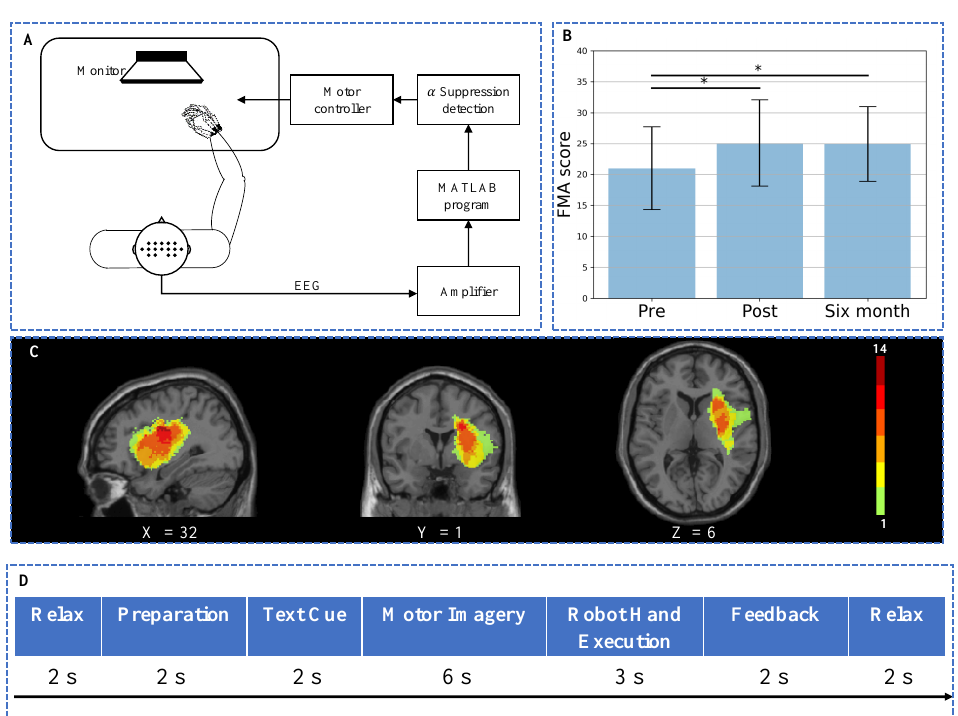
Figure 1. Illustration of the experimental settings and characteristics of subjects. ( A ) Schematic diagram of the whole training system. ( B ) Comparison of FMA score among pre-training, post- training, and six-month follow-up. Significant changes were seen in pre-training versus post-training and pre-training versus six-month follow-up. Error bars are standard errors. * p < 0.05. ( C ) Lesion distribution of stroke subjects. The color bar represents the number of patients with lesions in the corresponding areas. The annotation of X, Y, Z represented the coordinate of the slice in Montreal Neurological Institute (MNI) space. ( D ) The sequence of training